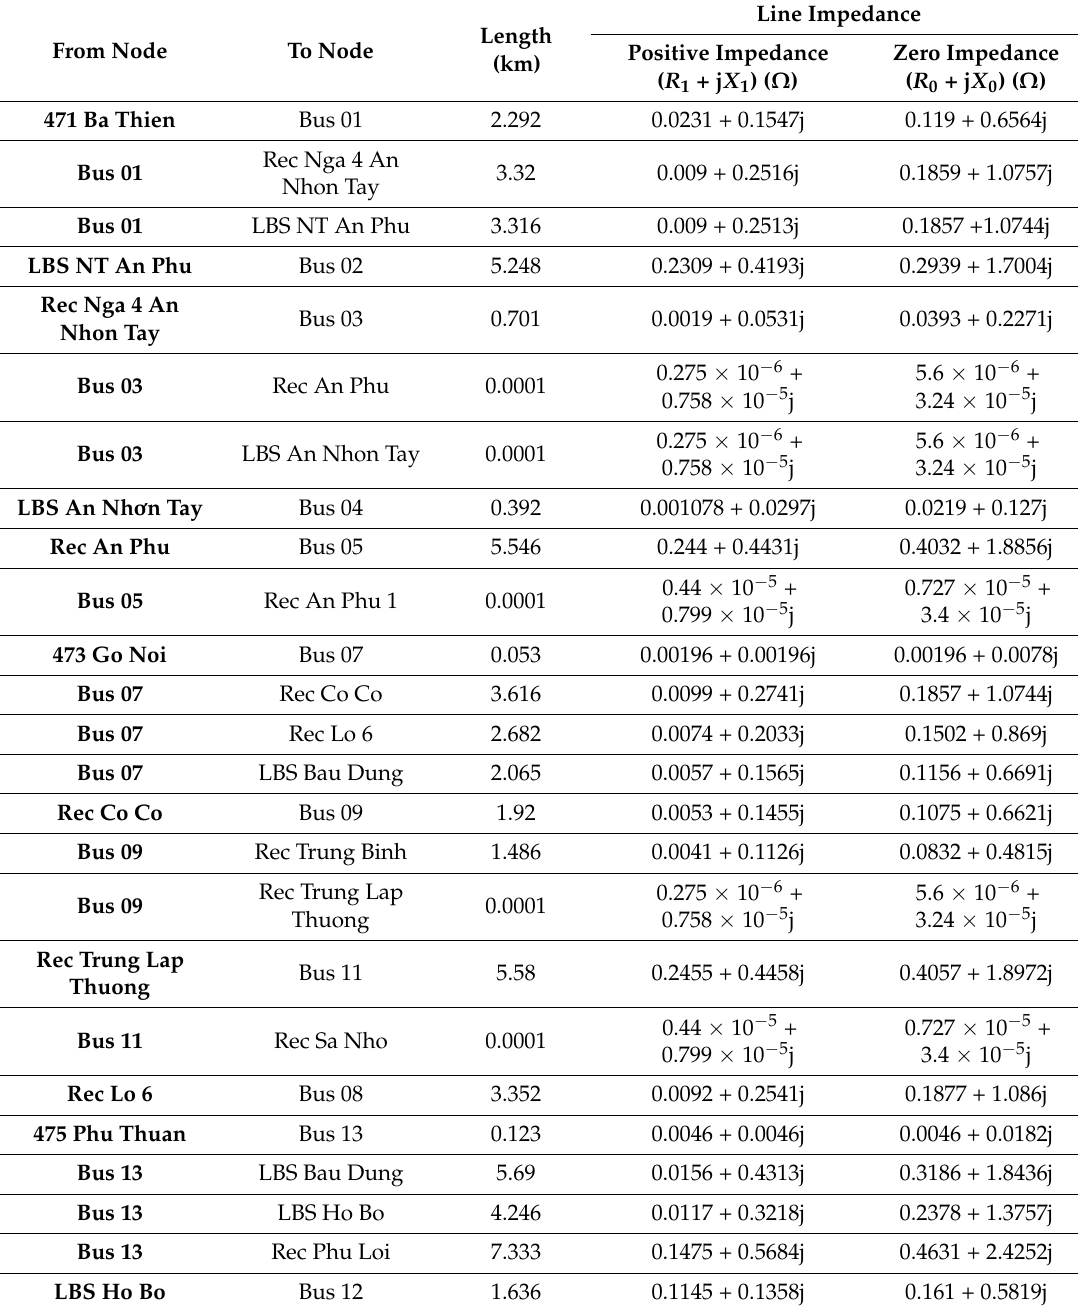
Table 6. Line parameters of a real 22 kV distribution system.